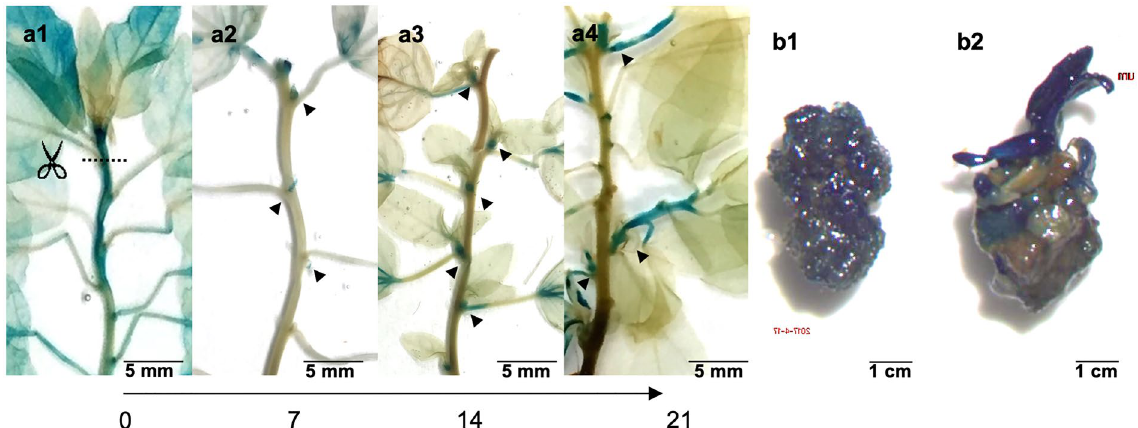
Fig. 4 Pcwpo-c :: GUS expression during axillary bud outgrowth and adventitious bud induction. a1 – a4 Axillary bud outgrowth induction. a1 Before stem tip decapitation (dotted line indicates decapitation position). a2 – a4 Sequence of axillary bud outgrowth (7, 14 and 21 days after decapitation, respectively). Black arrows indicate newly generated buds in the stem. b1 Callus. b2 Adventitious bud outgrowth on callus